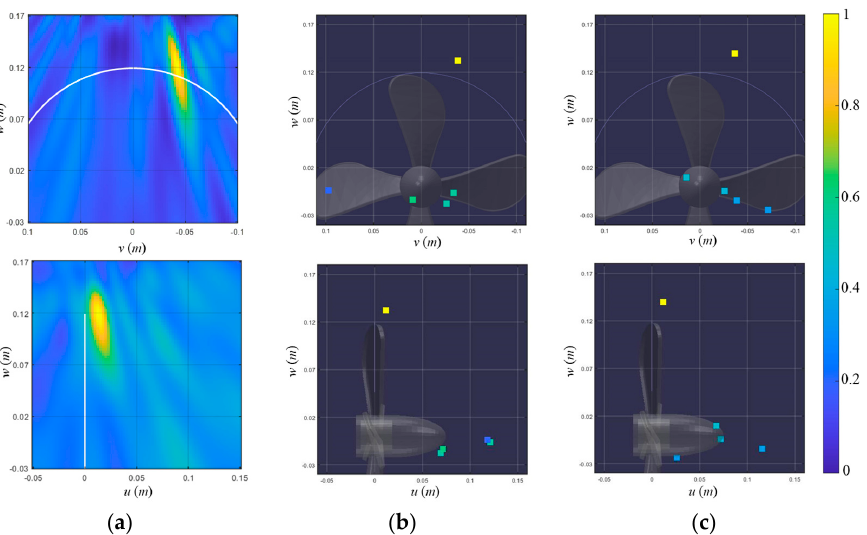
Figure 12. Localization results for the second cavitation event (signal 2) using ( a ) conventional beam- former, ( b ) off-grid BSBL, and ( c ) pairwise off-grid BSBL. The localization results are displayed onto the 𝑣 – 𝑤 (looking from the stern side) and 𝑢 – 𝑤 (looking from the port side) planes to visualize the 3D cavitation localization results.